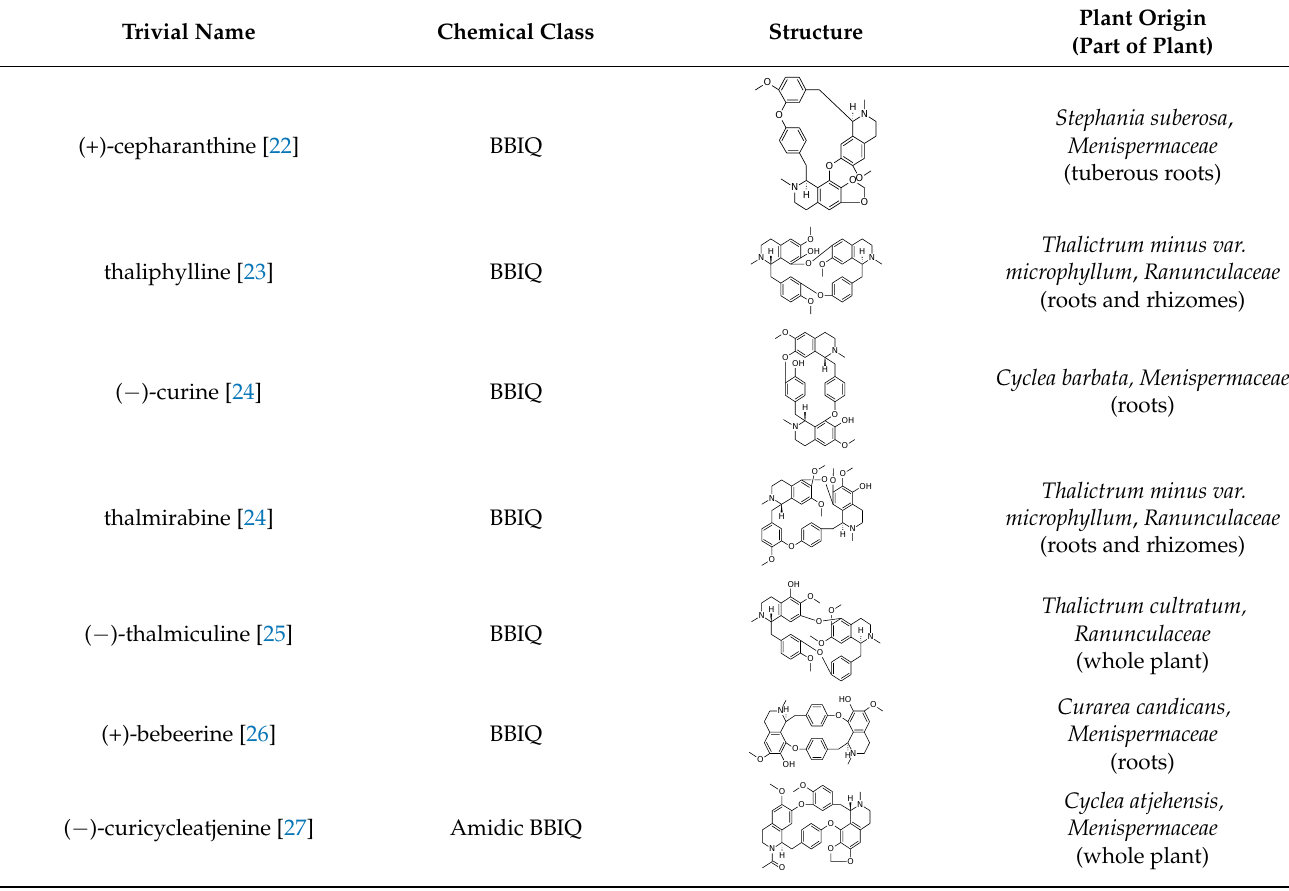
Table 1. Isoquinoline alkaloids (IAs) used in this work to screen for LTCC blockers.